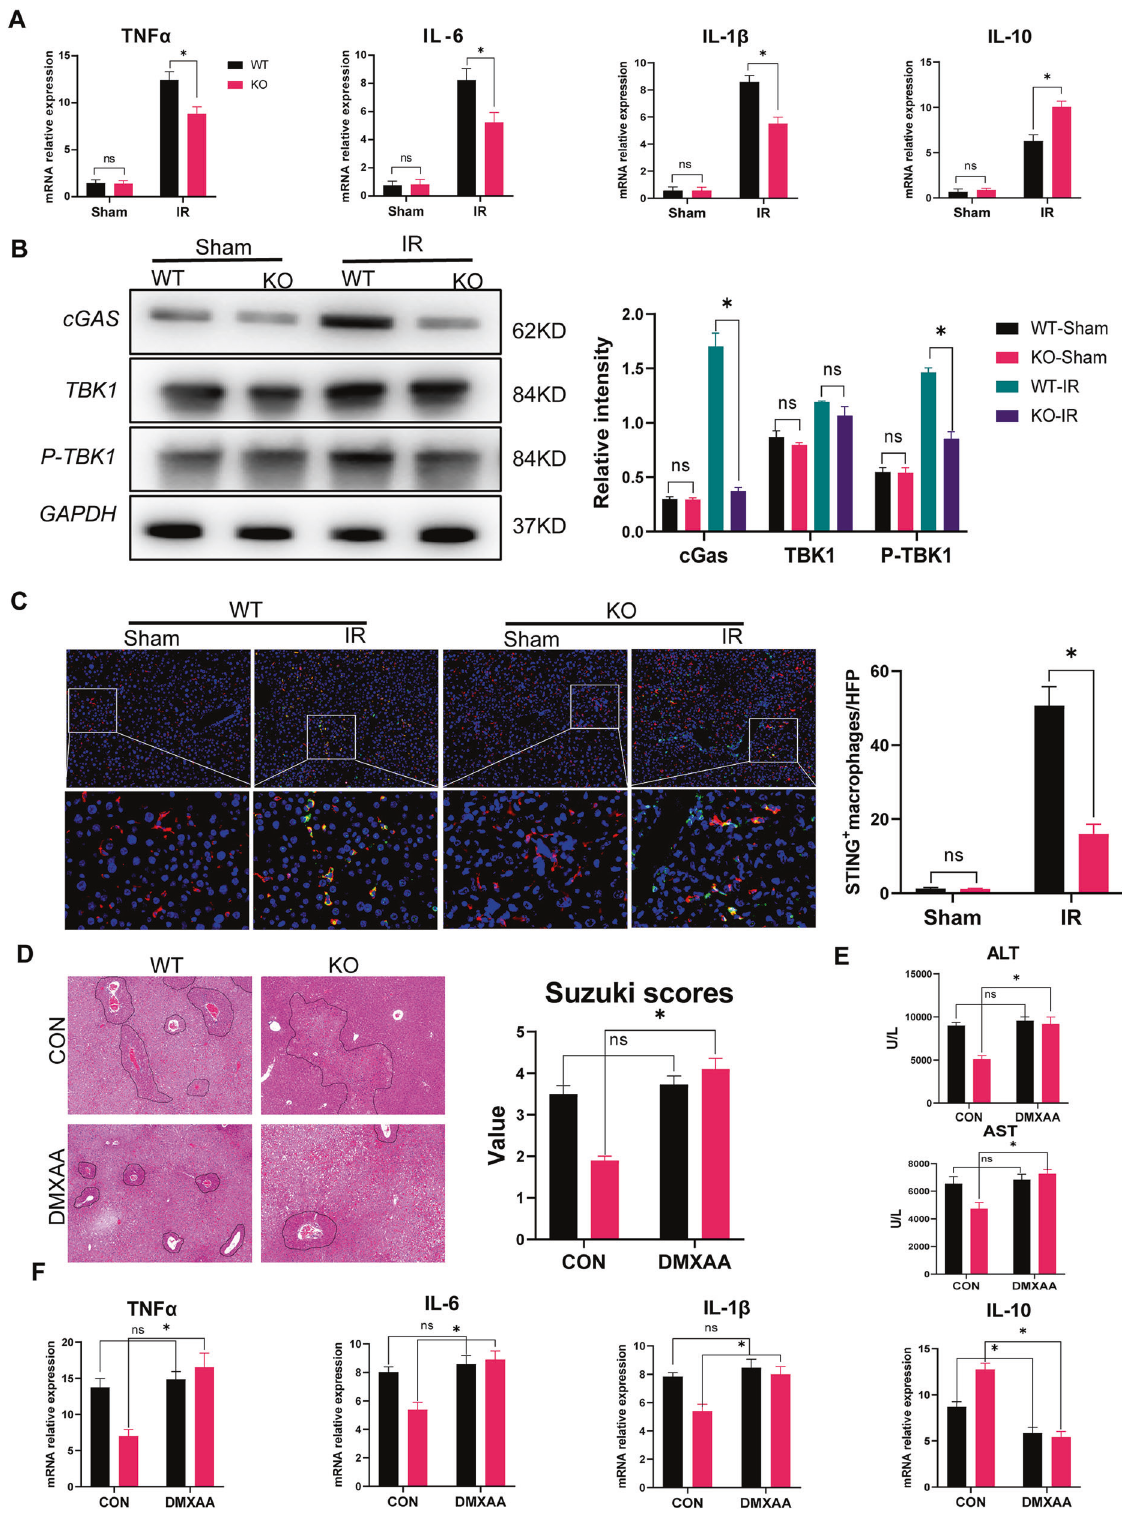
Fig. 2 MLKL depletion attenuated in fl ammatory liver IR injury by suppressing macrophage STING activation. WT and MLKL KO mice were subjected to liver IR model or sham procedure. Liver tissues, blood samples and intrahepatic macrophages were collected at 6 h post reperfusion. A Gene expression of TNF α , IL-1 β , IL-6 and IL-10 in liver tissues measured by qRT-PCR. B Expression of cGAS, TBK1, P-TBK1, and GAPDH in isolated intrahepatic macrophages measured by Western blot. C Immuno fl uorescence staining of DAPI (blue), F4/80 (red) and STING (green) in livers. WT and KO mice were pretreated with DMXAA (10 mg/kg) or PBS (Control) 3 h prior to ischemia. Mice were sacri fi ced 6 h poster reperfusion. D H&E ‐ staining of liver sections. E Serum levels of ALT and AST. F Gene expressions of TNF α , IL-1 β , IL-6 and IL-10 in livers measured by qRT ‐ PCR. n = 5 mice/group. All results represent at least two independent experiments. Values were expressed as mean ± SD. * p < 0.05.